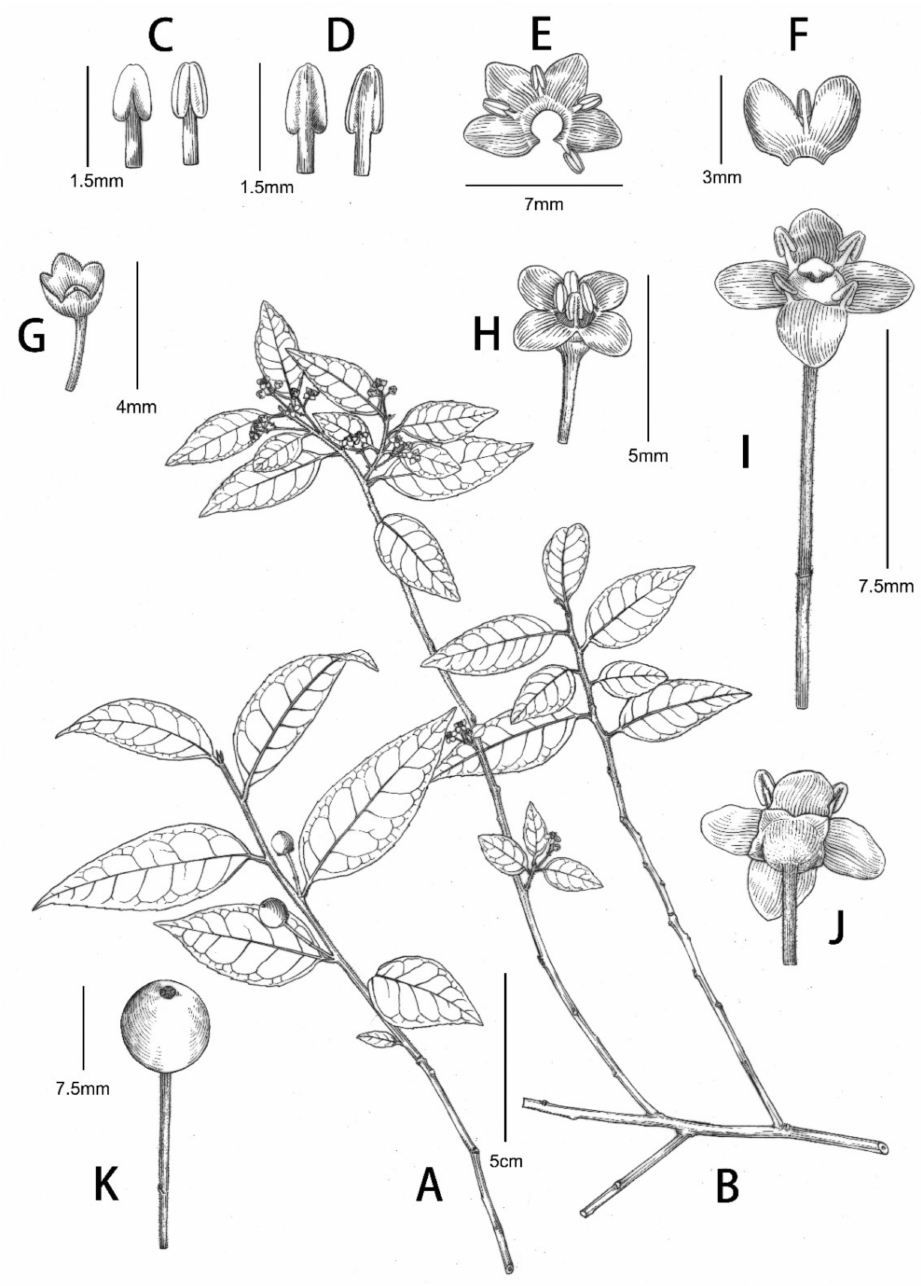
Figure 3. Ilex danxiaensis K. W. Xu & Q. Fan, sp. nov. ( A ) Fruiting branches; ( B ) female flowering branches; ( C ) fertile stamen; ( D ) staminodes; ( E ) petals and stamens of male flowers; ( F ) petals and staminodes of female flowers; ( G ) ciliate sepal; ( H ) male flower; ( I ) female flower; ( J ) dorsal view of male flower; ( K ) fruit. Drawn by Yun‑Xiao